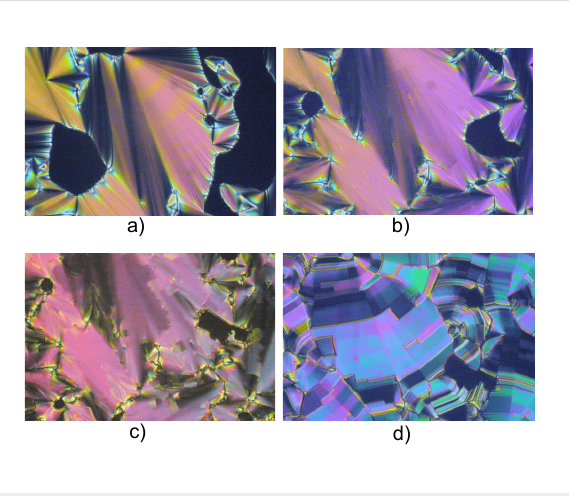
Figure 4: Optical textures of 16D[6] obtained for the same region of the sample upon cooling: (a) SmA growing from isotropic (251 °C), (b)